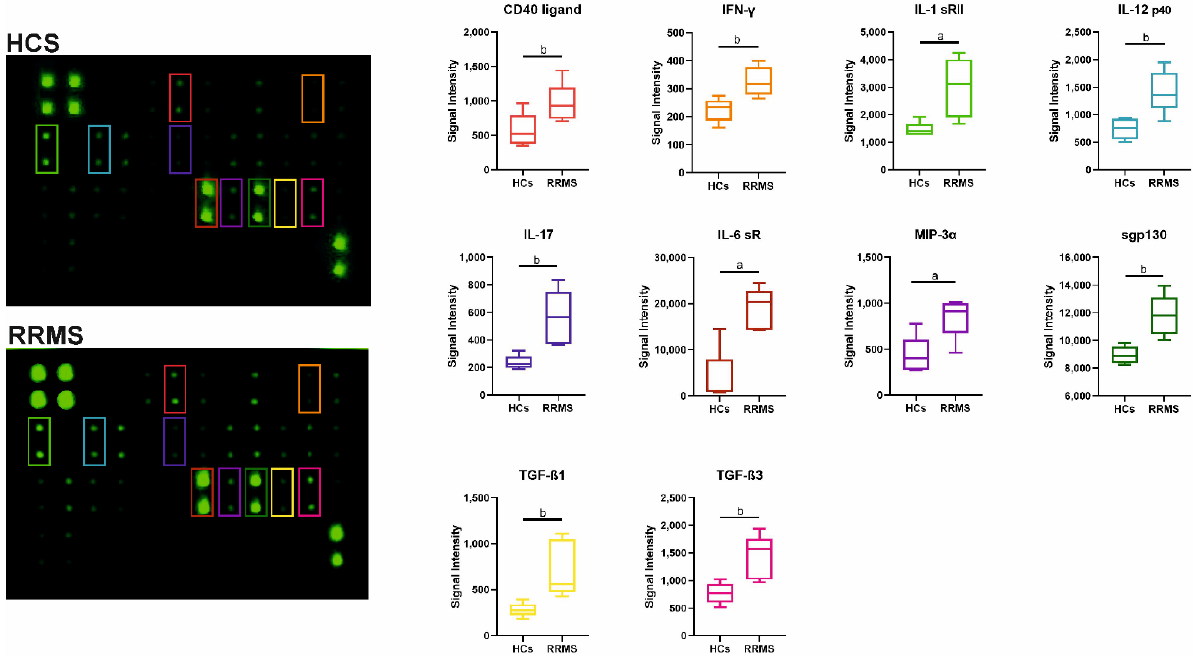
Figure 4. Identification of serum Th1/Th2/Th17 cytokines by antibody arrays. The serum cytokines differentially expressed between patients at pre-treatment (RRMS) and healthy controls (HC). Colored boxes indicate the locations of ten significantly different proteins on the arrays, and different colored boxes represent respective cytokines. Only those cytokines whose expression level (Relative Signal Intensity) differed in RRMS patients compared to the control are shown. Horizontal lines indicate significantly different groups a Mann–Whitney U ‐ test or b t ‐ Student test. RRMS n = 5, HC n = 5.